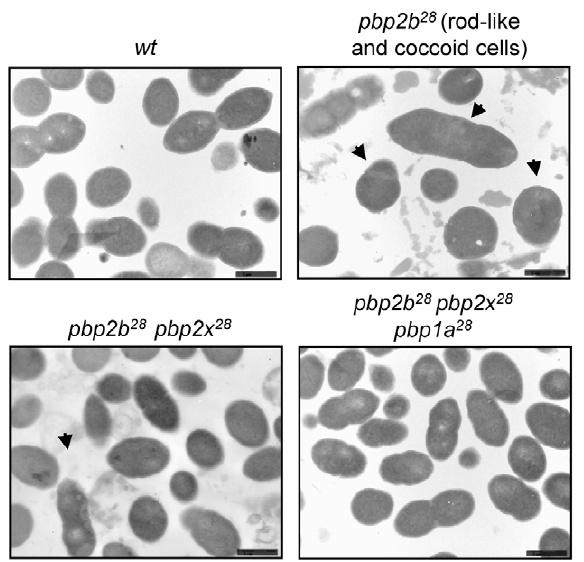
Figure 3. Electron microscopy analysis of cell morphology of pbp mutants. Microphotographs of the wild-type strain (Cp1015) revealed the typical morphology of S. pneumoniae , with a correct septum placement, division and symmetry of daughter cells. In the pbp2b 28 mutant, two subpopulations were identified, namely rod-like and coccoid cells. The rod-like shaped cells showed multiple septa with incorrect formation and placement. The coccoid-shape cells exhibited multiple septa and intracellular accumulation of the cell wall, with the atypical septum localization resulting in irregular cell divisions and asymmetrical daughter cells (see arrows). The pbp2b 28 pbp2x 28 mutant partially restored the coccoid morphology, but conserved some cell alterations similar to those of the single pbp2b 28 mutant. The triple pbp mutant showed a similar morphology to wt cells. Additional micropho- tographs are shown in Figs. S12, S13, S14 and S15 in